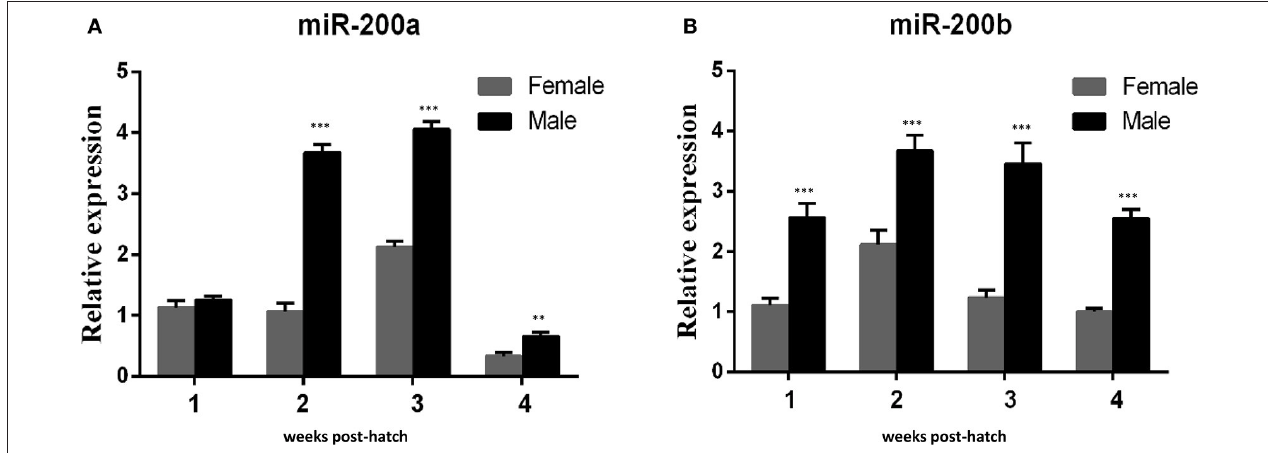
FIGURE 2 | Expression of miR-200a and miR-200b in juvenile fish among 1–4 weeks post hatching. (A,B) indicated the relative expression levels of miR-200a and miR-200b during juvenile fish, respectively (** P < 0.01 and *** P < 0.001).